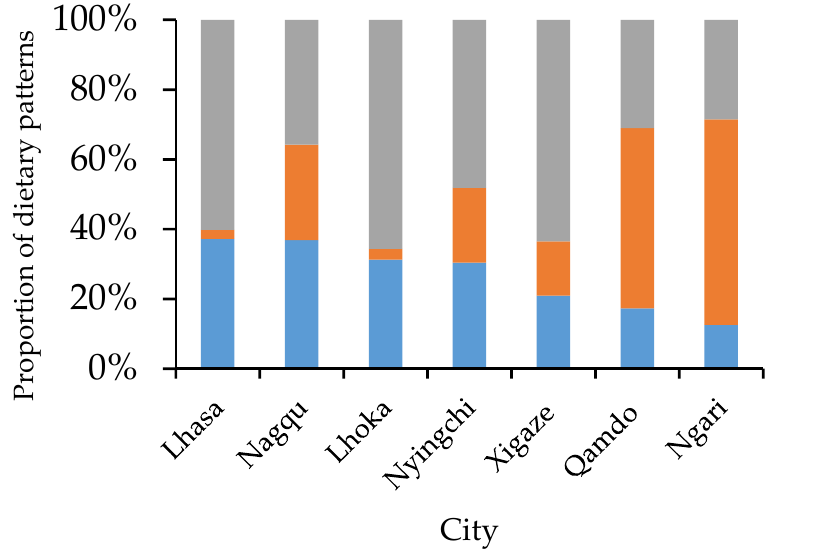
Figure 4. Proportion of dietary patterns in cities.